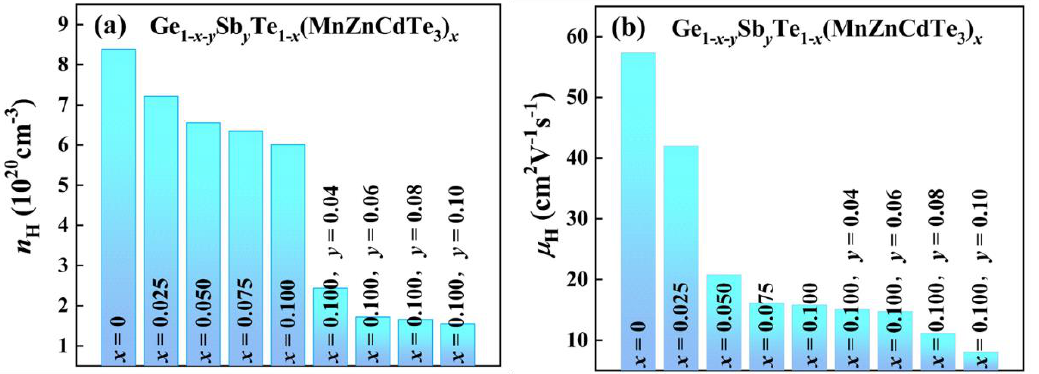
Figure 3. The room temperature ( a ) carrier concentration n H , and ( b ) carrier mobility μ H of Ge 1− x − y S- b y Te 1− x (MnZnCdTe 3 ) x